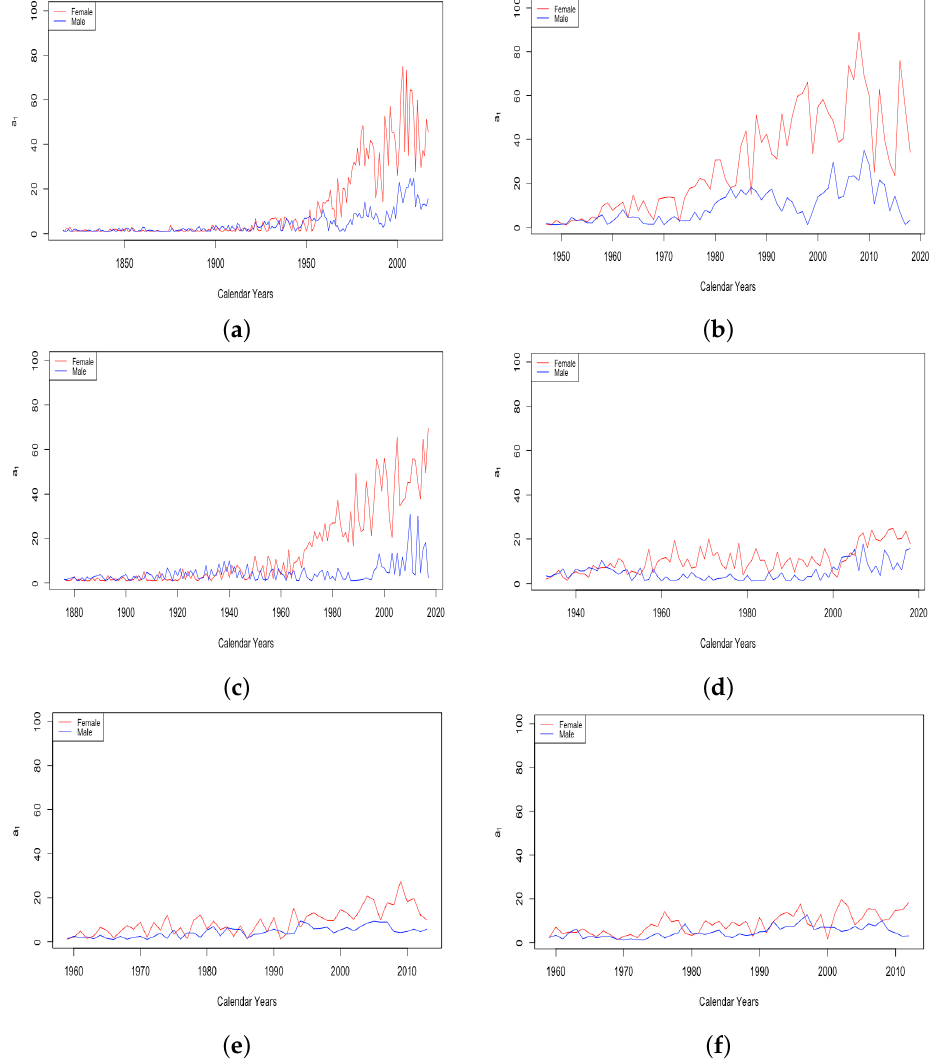
Figure 18. ( a ) The log of mortality deceleration factor a 1 before age 65 in in France. ( b ) The log of mortality deceleration factor a 1 before age 65 in in Japan. ( c ) The log of mortality deceleration factor a 1 before age 65 in in Switzerland. ( d ) The log of mortality deceleration factor a 1 before age 65 in in the USA. ( e ) The log of mortality deceleration factor a 1 before age 65 in in Russia. ( f ) The log of mortality deceleration factor a 1 before age 65 in in